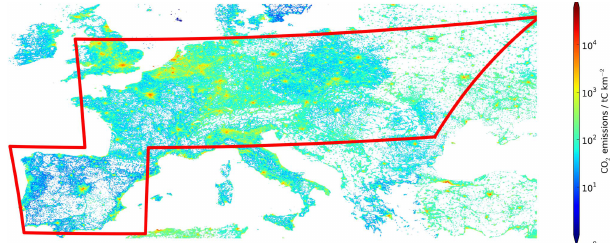
Figure 1. Illustrative G3E scan pattern to be covered from east to west within 2h (red polygon). The assumed scan pattern would con- sist of a long east-to-west scan for central Europe and a second short scan for the Iberian peninsula. The background color code shows annual CO 2 emissions for the year 2013 as extracted from the database built by Oda and Maksyutov